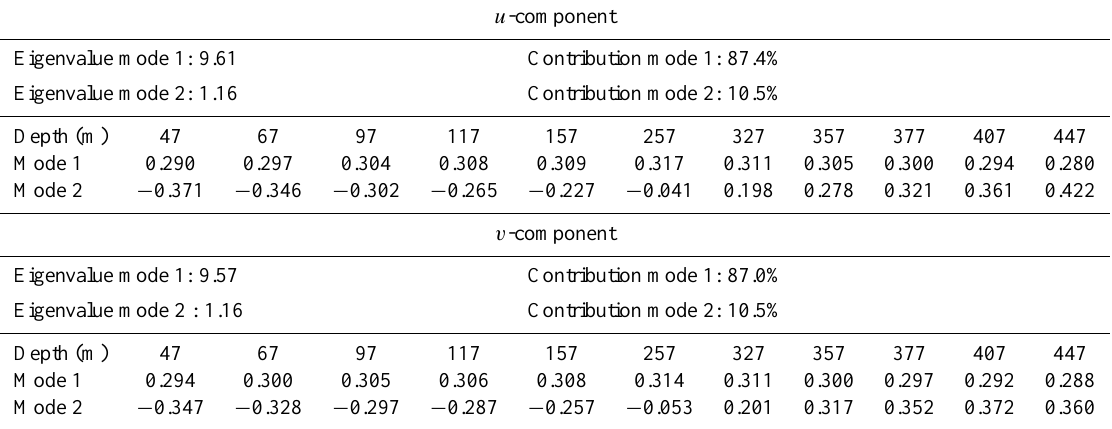
Table 3. EOF eigenvectors and total variance explained for the u and v current components during the first phase (04 Mar 2000 – 01 Jul 2000; J.D. 64 – J.D. 183)